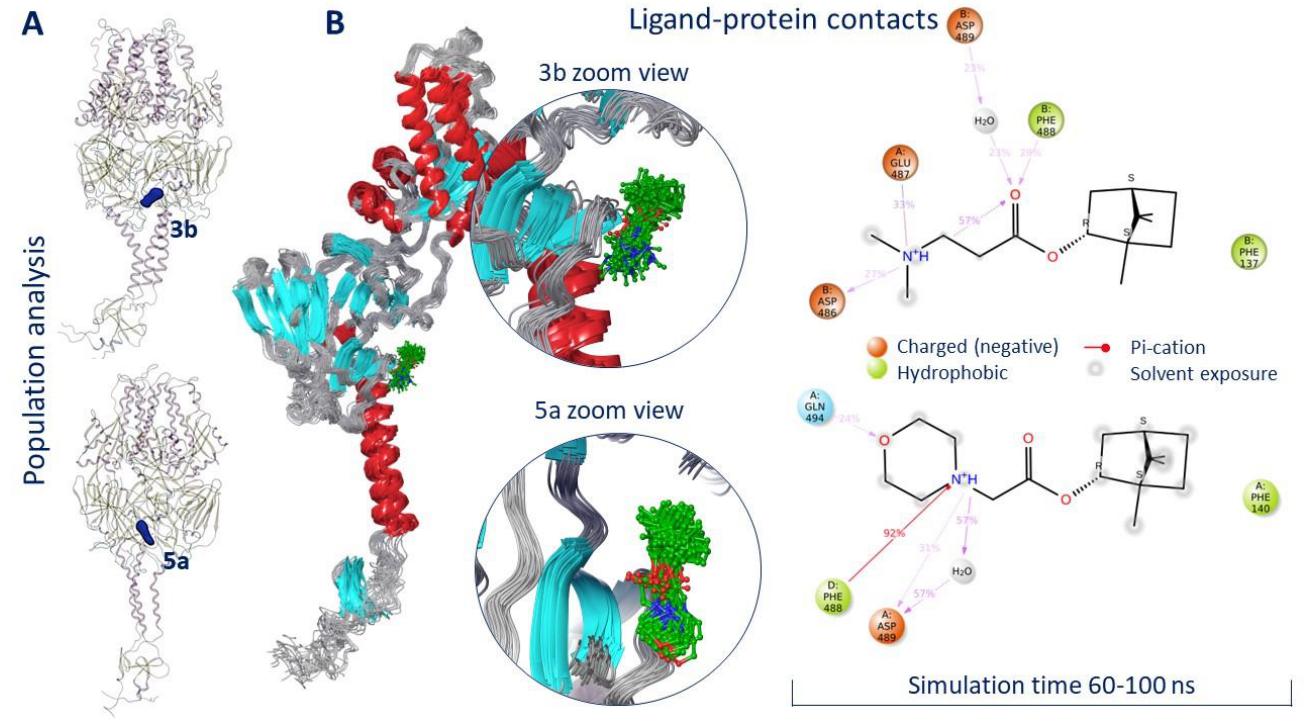
Figure 5. Populationanalysis( A )andligand–proteincontacts( B